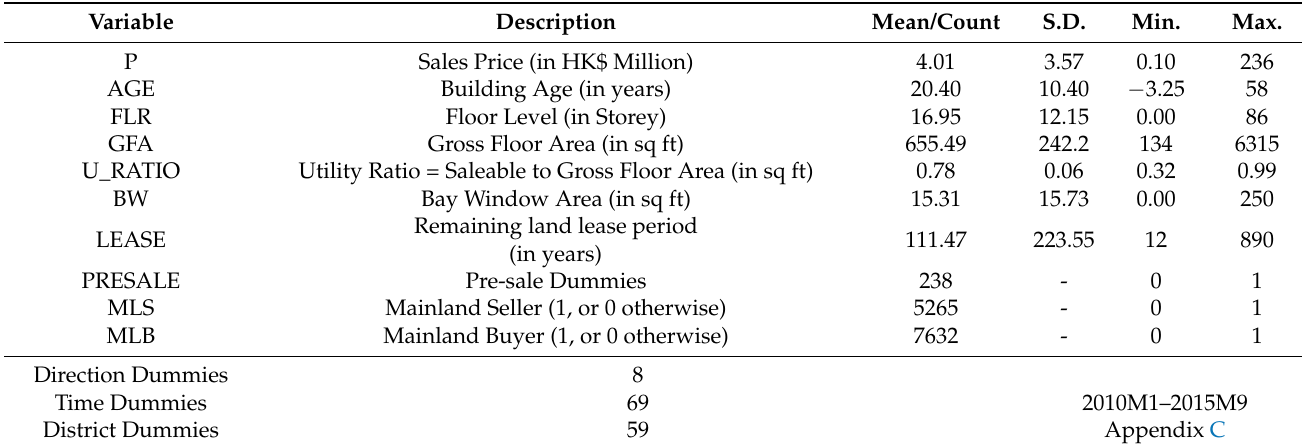
Table 2. Summary statistics of variables for the hedonic price